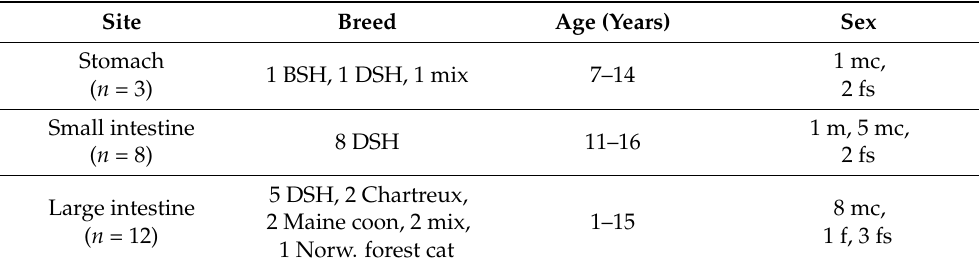
Table 6. Polyps of the feline gastrointestinal tract in the present study ( n = 23).